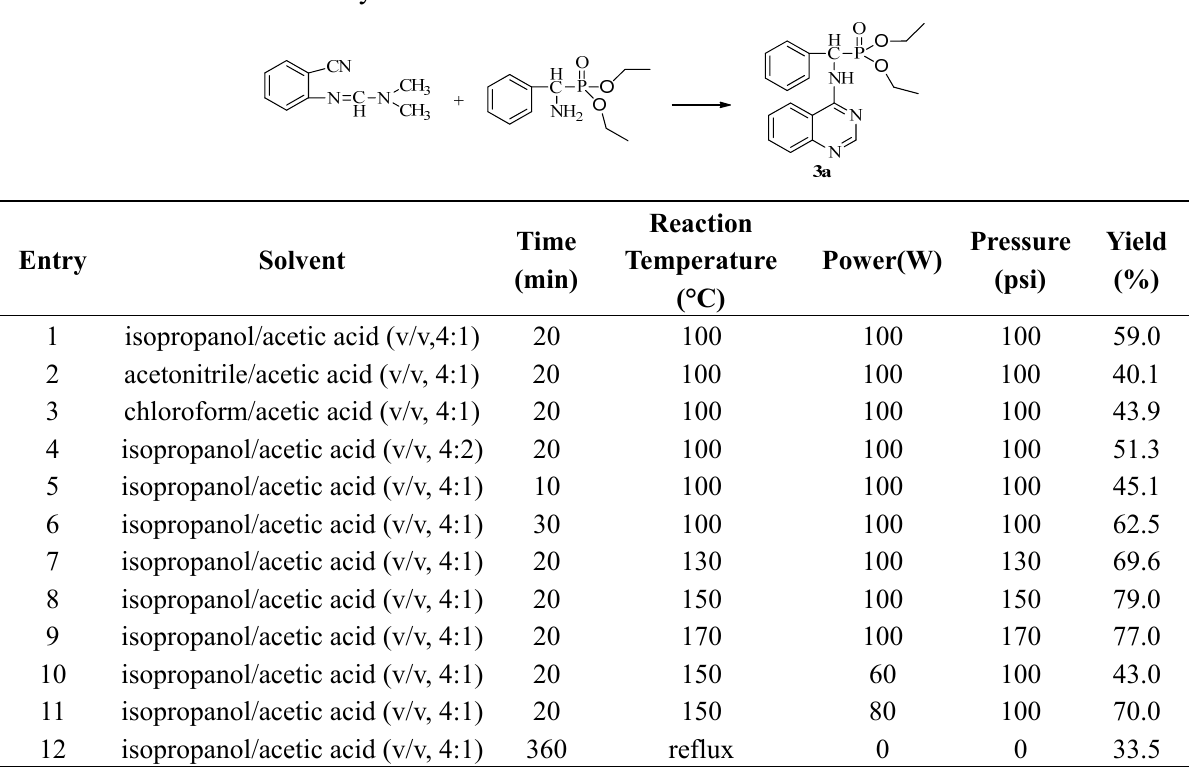
Table 1. Synthesis of 3a under different reaction